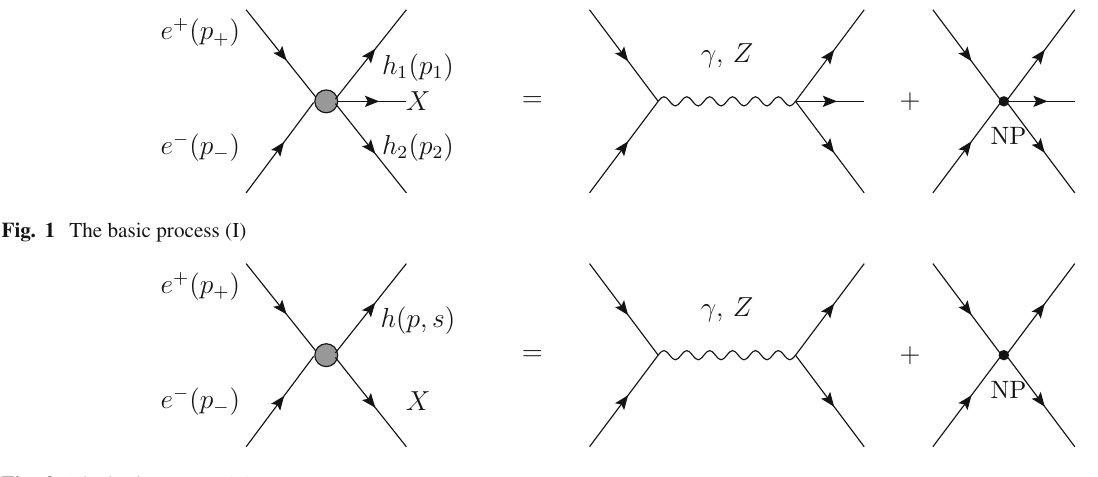
Fig. 2 The basic process